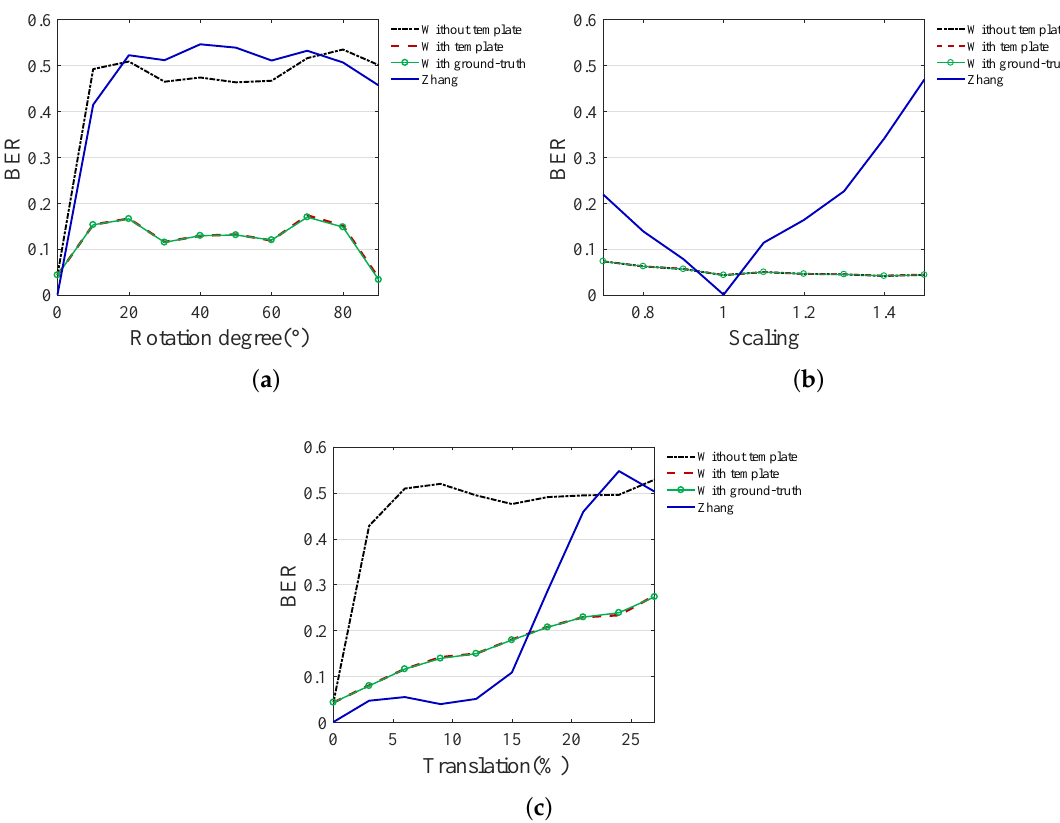
Figure 9. Robustness results for geometric distortions. ( a ) rotation, ( b ) scaling, ( c ) translation. The method with the proposed template recovery and the method with ground-truth recovery show almost the same